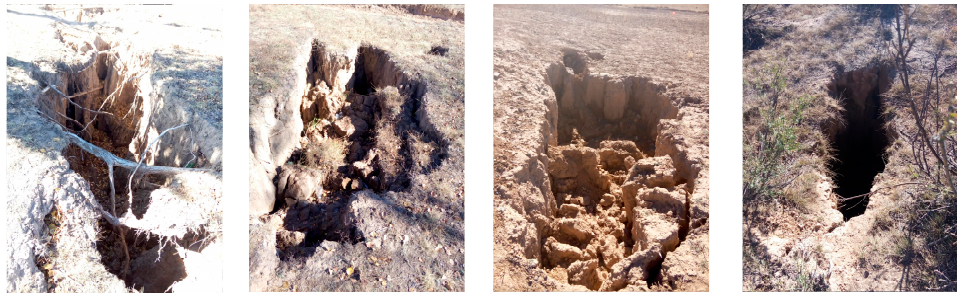
Figure 2. Ground fissure and collapse in the study area.